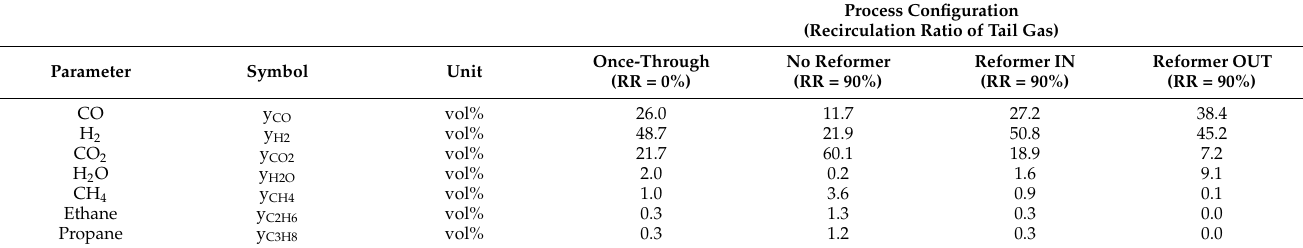
Table 5. Tail gas composition for process configurations with and without a tail gas